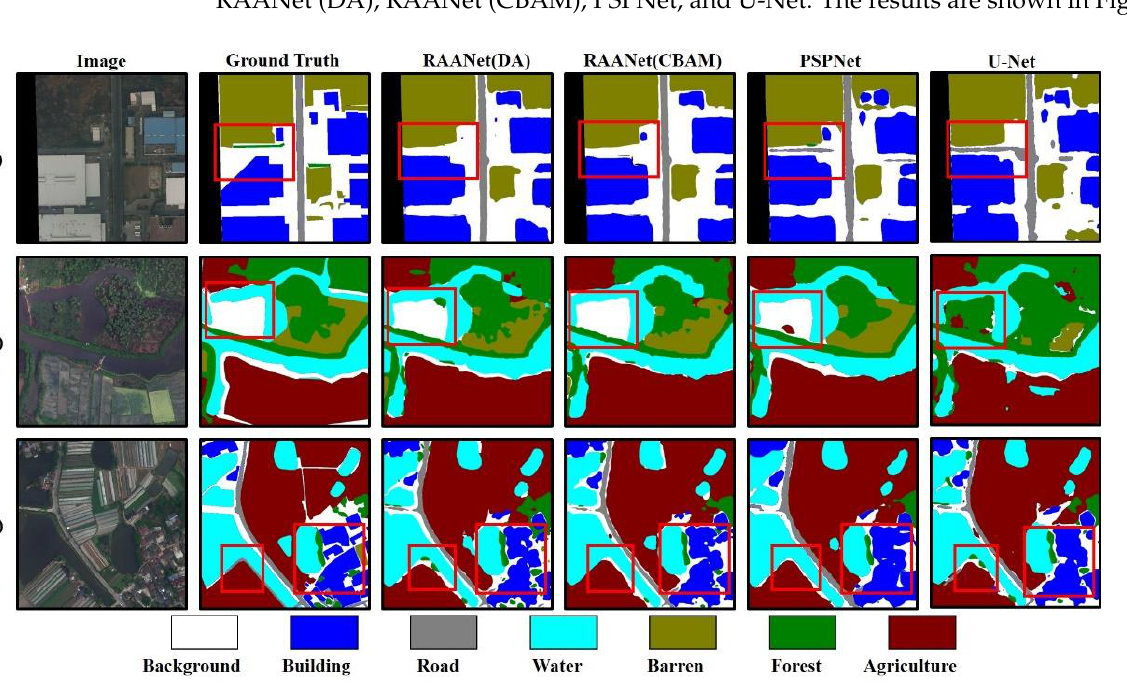
Figure 8. Prediction results of the different semantic segmentation models. ( 1 – 3 ) represents three random parts of the experimental sample random parts of the experimental